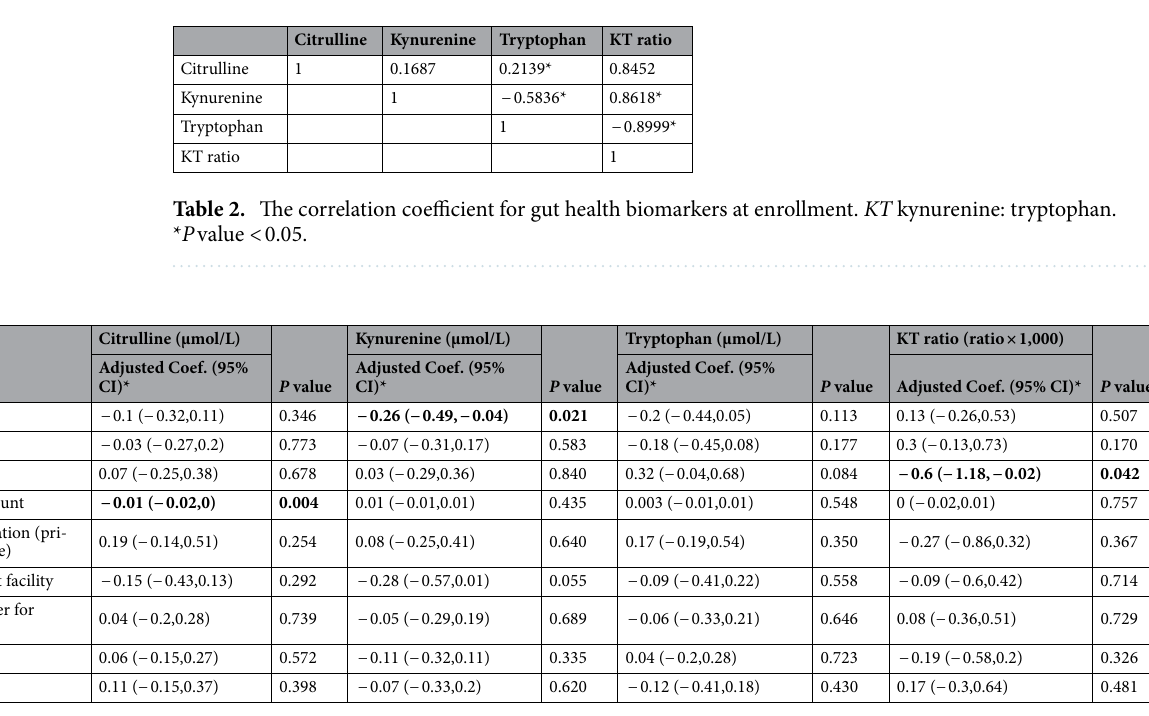
Table 3. Gut health biomarkers at baseline and associated predictors. Coef.: coefficient; 95% CI: 95% confidence interval; Models adjusted for all the variables mentioned in the table at enrollment. Values represent the beta coefficient and 95% CI from linear regression models. For continuous predictors, this represents the change in outcome corresponding to a one-unit increase in the predictor. For dichotomous predictors, this corresponds to the change in mean concentration from the reference